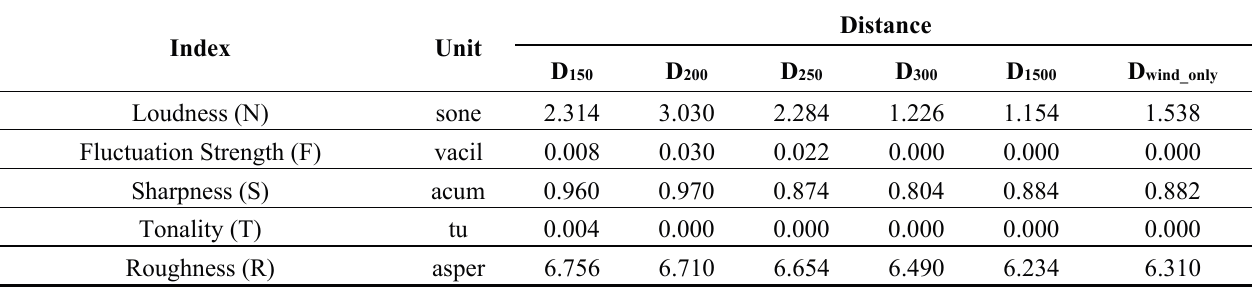
Table 2. Psychoacoustic indexes. Mean values at the six distances.